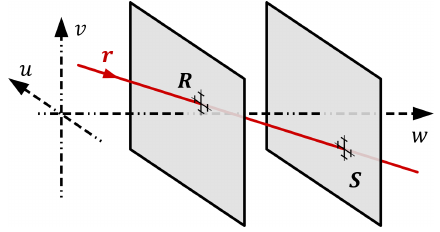
Figure 3. Sketch of the sensing setup for the detection of a ray direction.